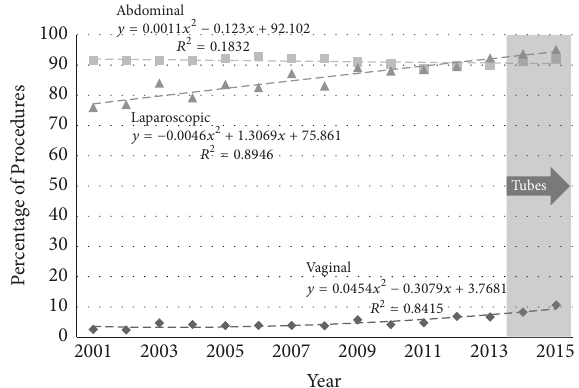
Figure 4: Age-stratified incidence rates for different routes of hysterectomy ( X vaginal, ◼ abdominal, and 󳵳 laparoscopic) in Australia (procedures per 10000 women) for women aged 35–54 years.